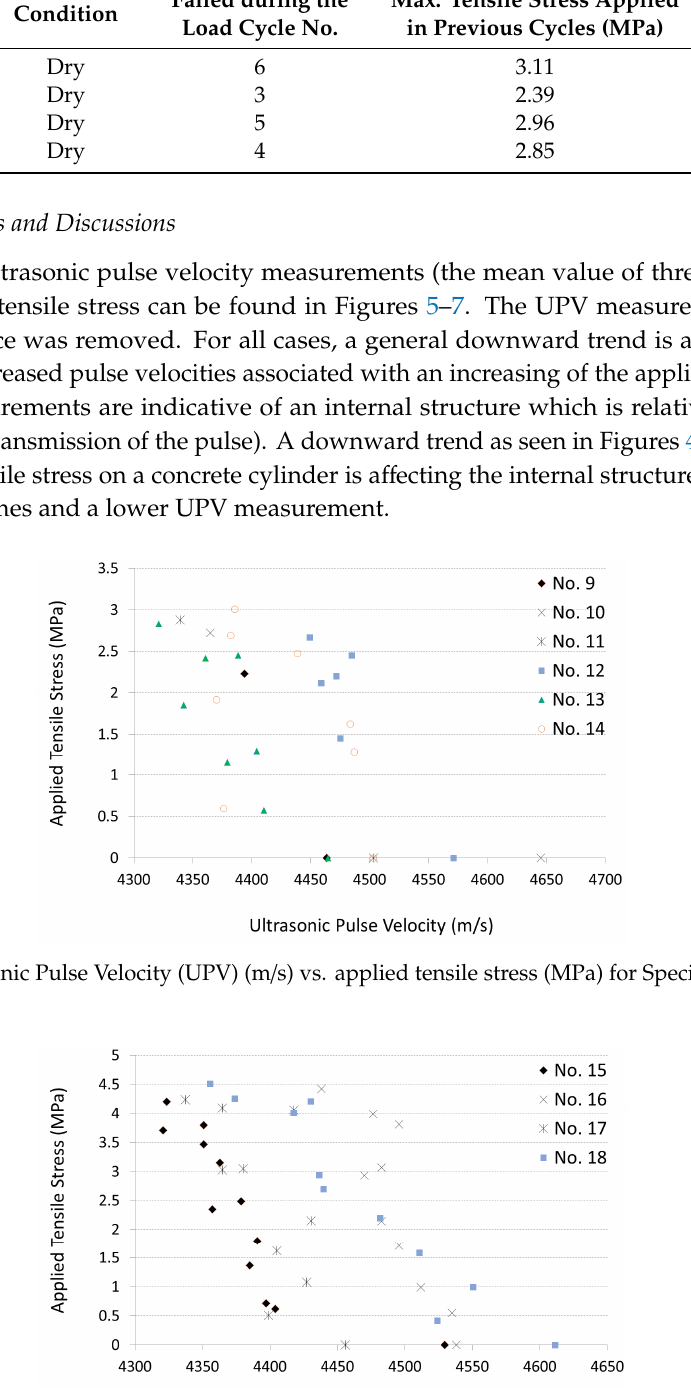
Table 6. Cyclic load results for specimens 19 to 22.